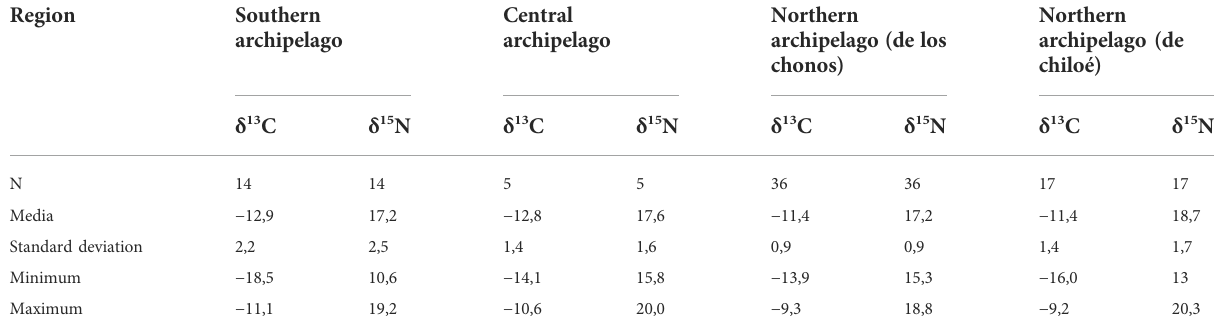
TABLE 1 Descriptive statistics of the δ 15 N and δ 13 Ccol values of the canoe groups that inhabited the Patagonian archipelago. References used: Alfonso-Durrrutyetal.,2015;Barberena2002;Borreroetal.,2001;Kochi2017;Panarelloetal.,2006;Reyesetal.,2019b,2022;Tafurietal.,2017; Tessone et al., 2003; Yesner et al., 2003.